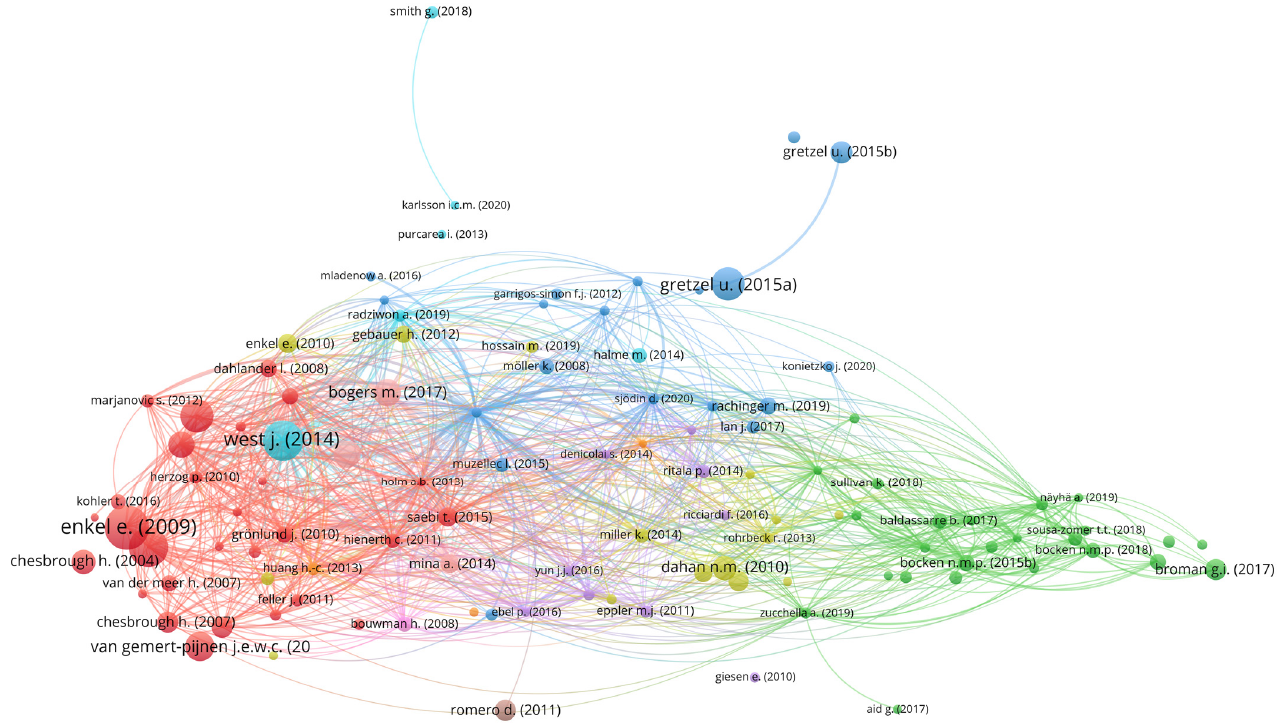
Figure 11. Bibliographic coupling network of documents in the BM&OI literature.